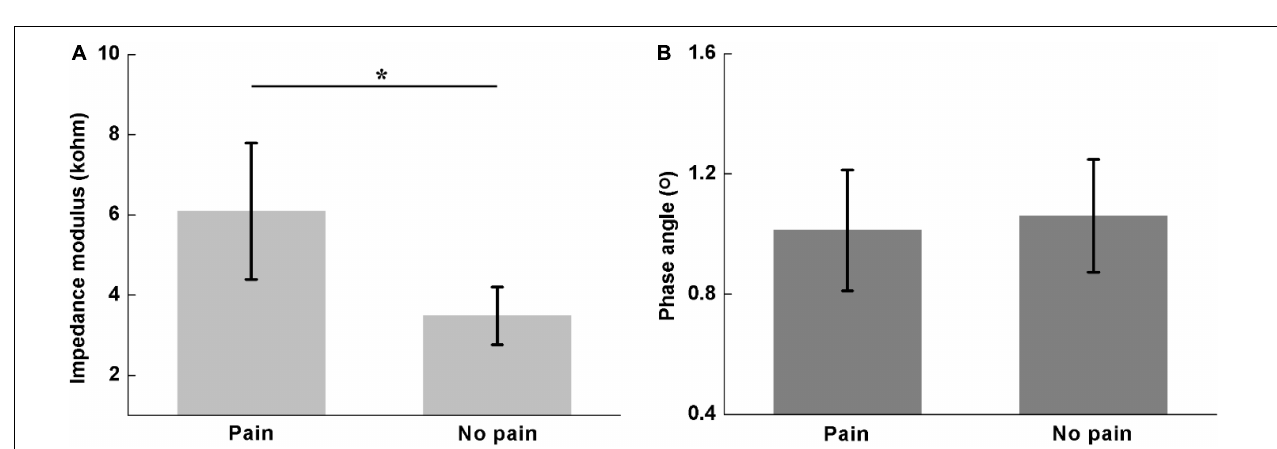
FIGURE 4 | Comparisons of the sum of lumbar muscle impedance on both sides between participants with and without LBP, including (A) impedance modulus (pain: 6.09 ± 1.70; no pain: 3.48 ± 0.72) and (B) phase angle (pain: 1.01 ± 0.20; no pain: 1.06 ± 0.19). *denotes P <